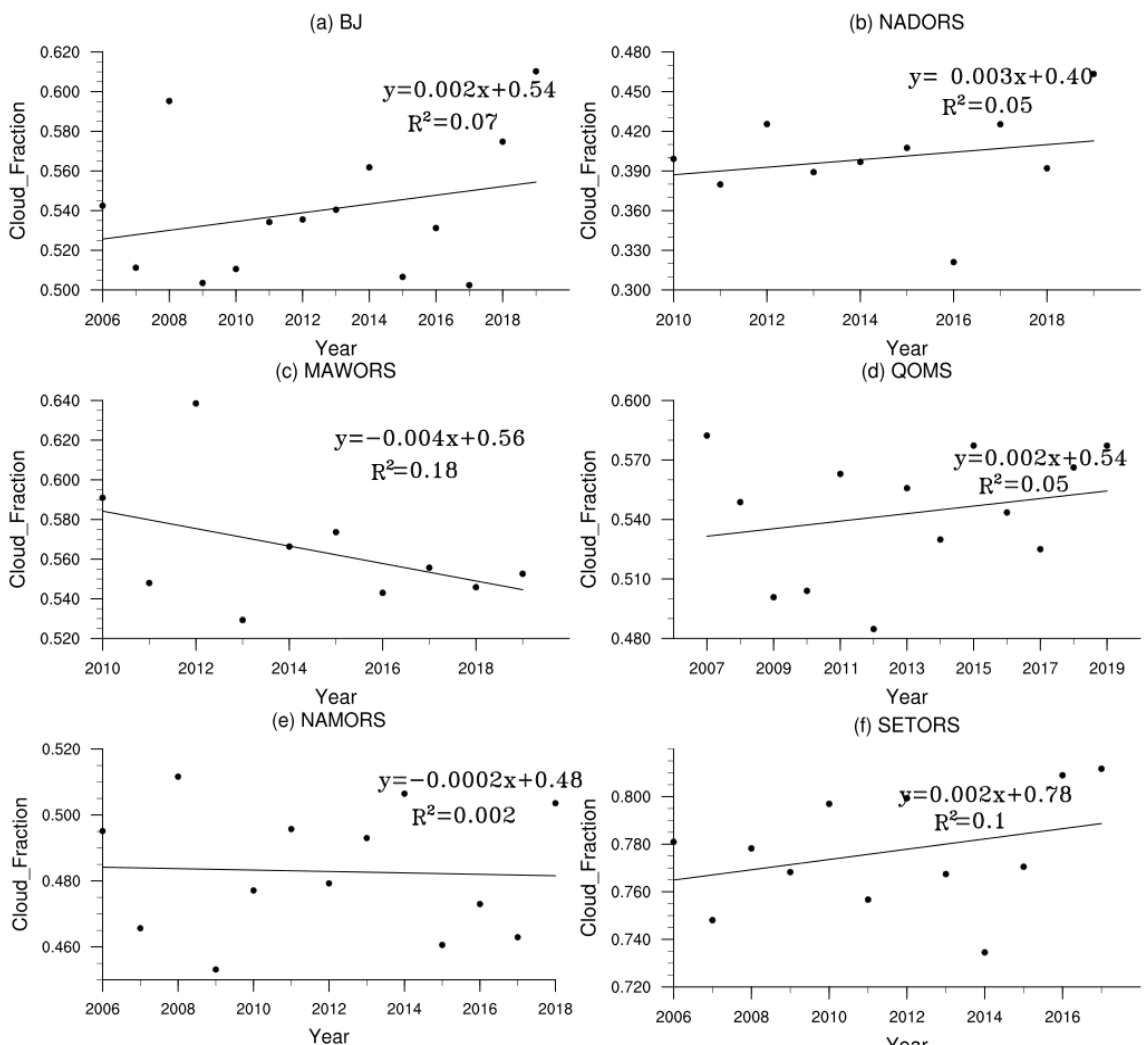
Figure 6. Interannual variation of cloud fraction at each station. The intra-annual variations of downward shortwave radiation at each station (Figure 7a) showed a gradual increase with increasing solar altitude angle, starting from January. However, the downward shortwave radiation at BJ, QOMS, NAMORS, and NADORS did not reach their maximum in summer when the solar altitude angle was at its maximum, but in spring (when it reached a maximum of 620 W · m − 2 ). Spring represents the early stage of the monsoon outbreak, characterized by low soil humidity, low cloudiness, and strong downward shortwave radiation. In summer, the monsoon is in its outbreak period: precipitation increases, the water vapor content increases, the air becomes more humid, and there is a corresponding decrease in atmospheric transparency, which results in less downward shortwave radiation reaching the ground. The downward shortwave radiation fluctuated between 450 W · m − 2 and 550 W · m − 2 at each station. In autumn and winter, the downward shortwave radiation decreased with the decreasing solar altitude angle. The annual variation of downward shortwave radiation at QOMS was obvious. The difference between the downward shortwave radiation in spring and summer reached 200 W · m − 2 . The annual variation of downward shortwave radiation at SETORS fluctuated relatively weakly, between 300 W · m − 2 and 400 W · m − 2 . MAWORS is located in the northwestern part of the Tibetan Plateau, far inland, and is almost unaffected by the summer monsoon. At that site the downward shortwave radiation reached its maximum in